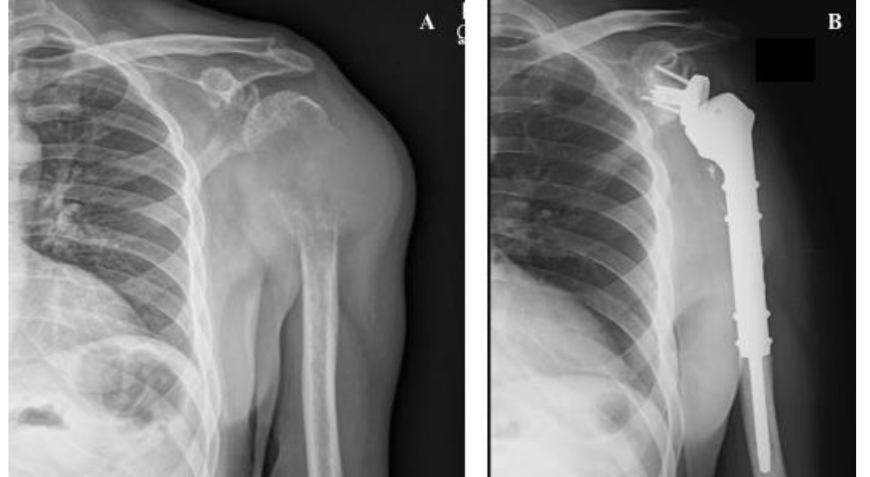
Figure 5. Shoulder megaprosthesis in a solitary proximal humerus lung metastasis: ( A ) preoperative image showing the left humerus with pathologic fracture secondary to lung carcinoma. An important soft tissue component is visible. ( B ) Postoperative image showing shoulder reverse mega- prosthesis.